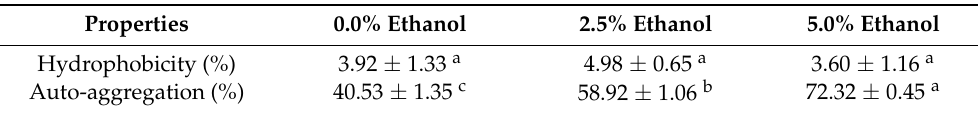
Table 2. Influence of subinhibitory concentrations of ethanol (1/4 MIC, 2.5%; 1/2 MIC, 5.0%) on cell surface characteristics of S .